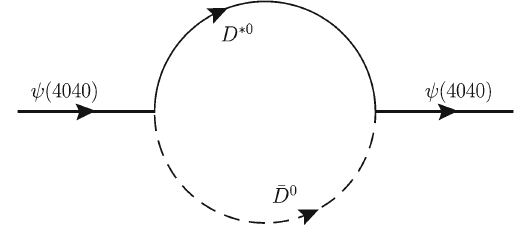
Fig. 1 Example of one-loop contribution. Here the case of D ∗ 0 and ¯ D 0 is